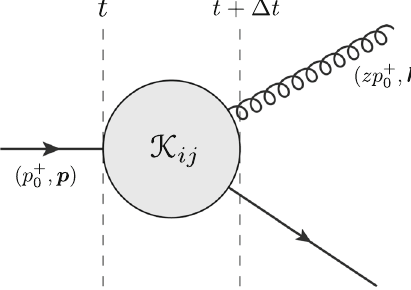
Fig. 1 Illustration of the splitting function K ij ( Q , z , t ) for the q → g + q splitting, where Q = k − z